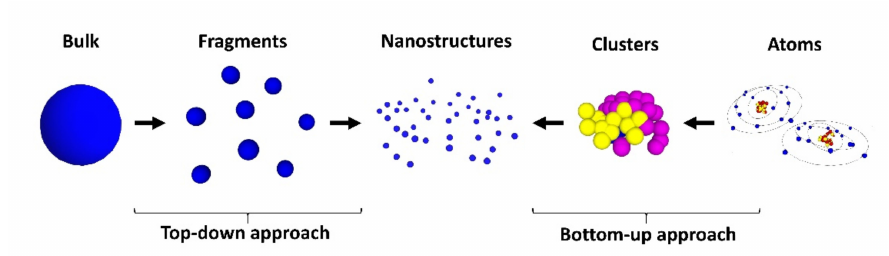
Figure 1. Top-down and bottom-up approaches used in nanofabrication.